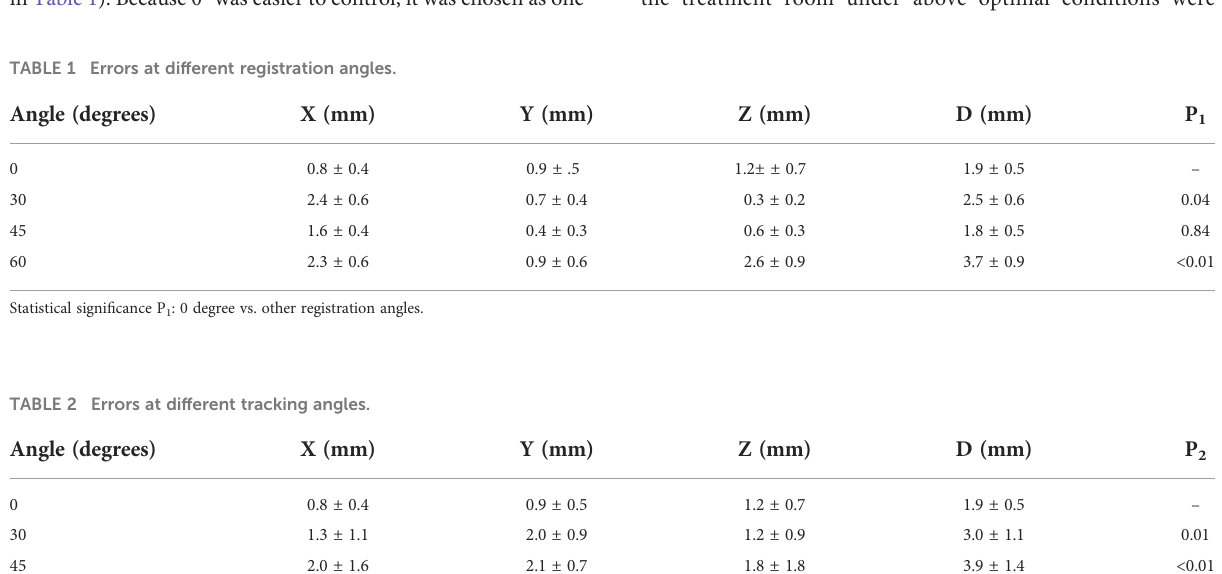
Statistical signi fi cance P 2 : 0 degree vs. other tracking angles.